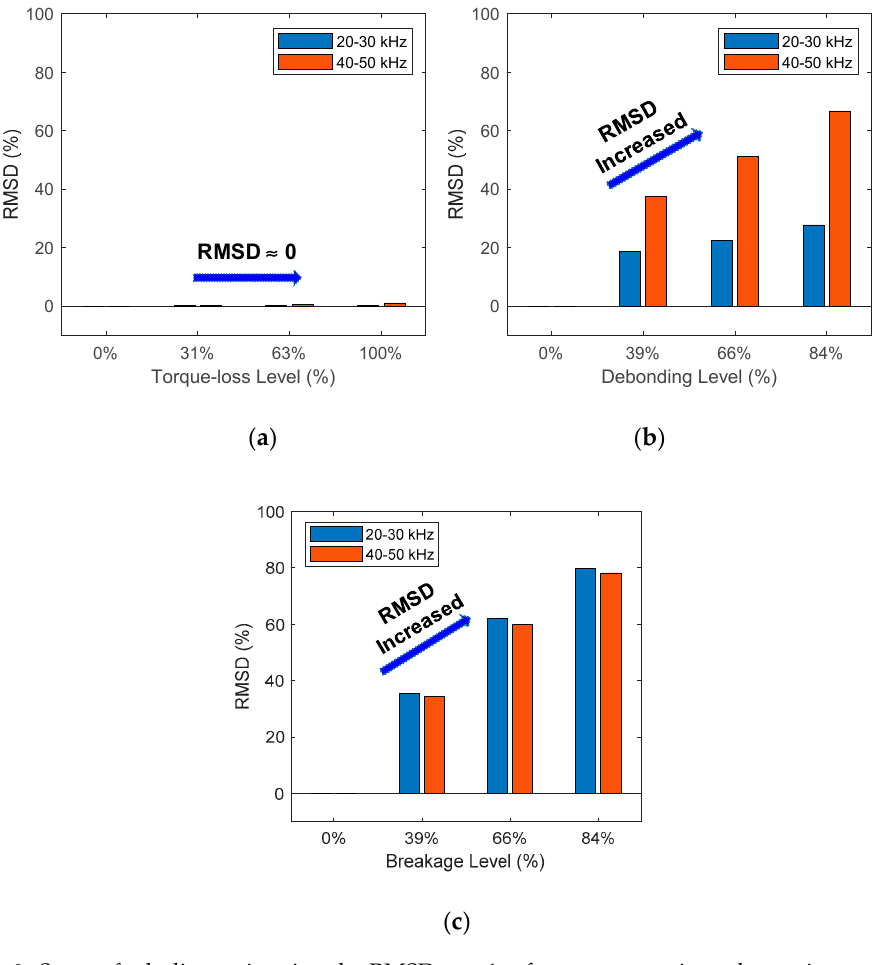
Figure 8. Sensor fault diagnosis using the RMSD metric of non-resonant impedance signatures: ( a ) structural damage; ( b ) sensor debonding; ( c ) sensor breakage.